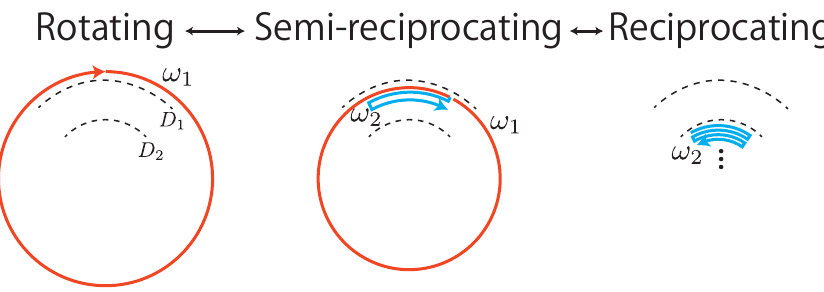
Figure 7. Three control modes of direct drive motor. Angular velocities during rotation and recipro- cation are ω 1 and ω 2 ,